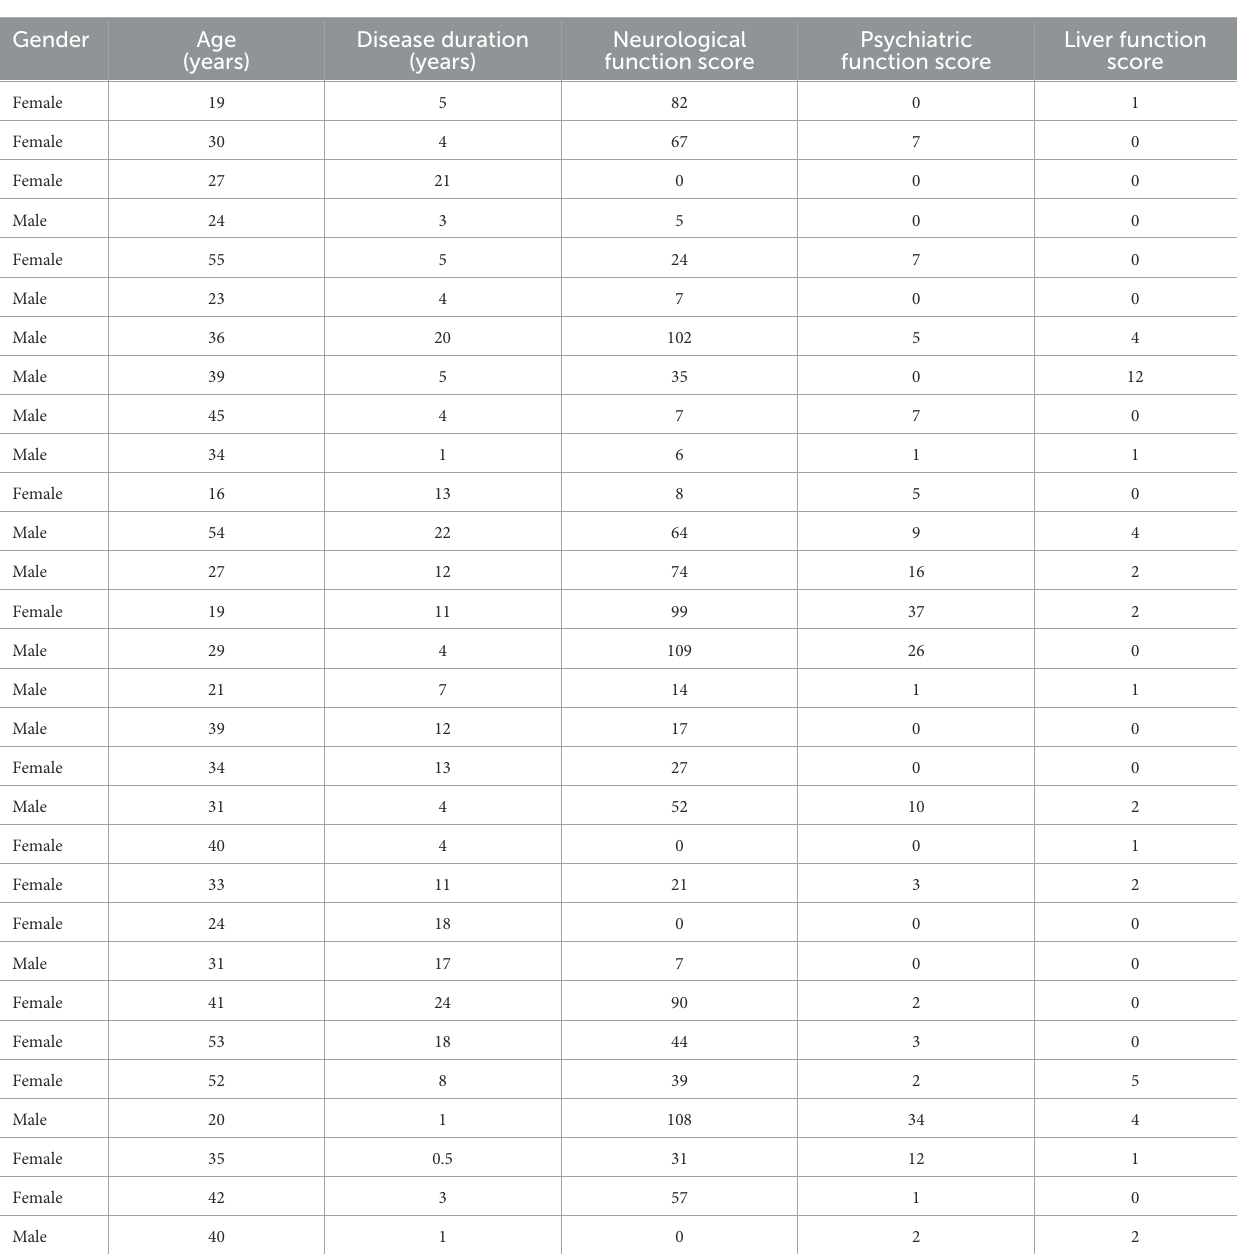
TABLE 1 Basic information of 30 patients with WD.